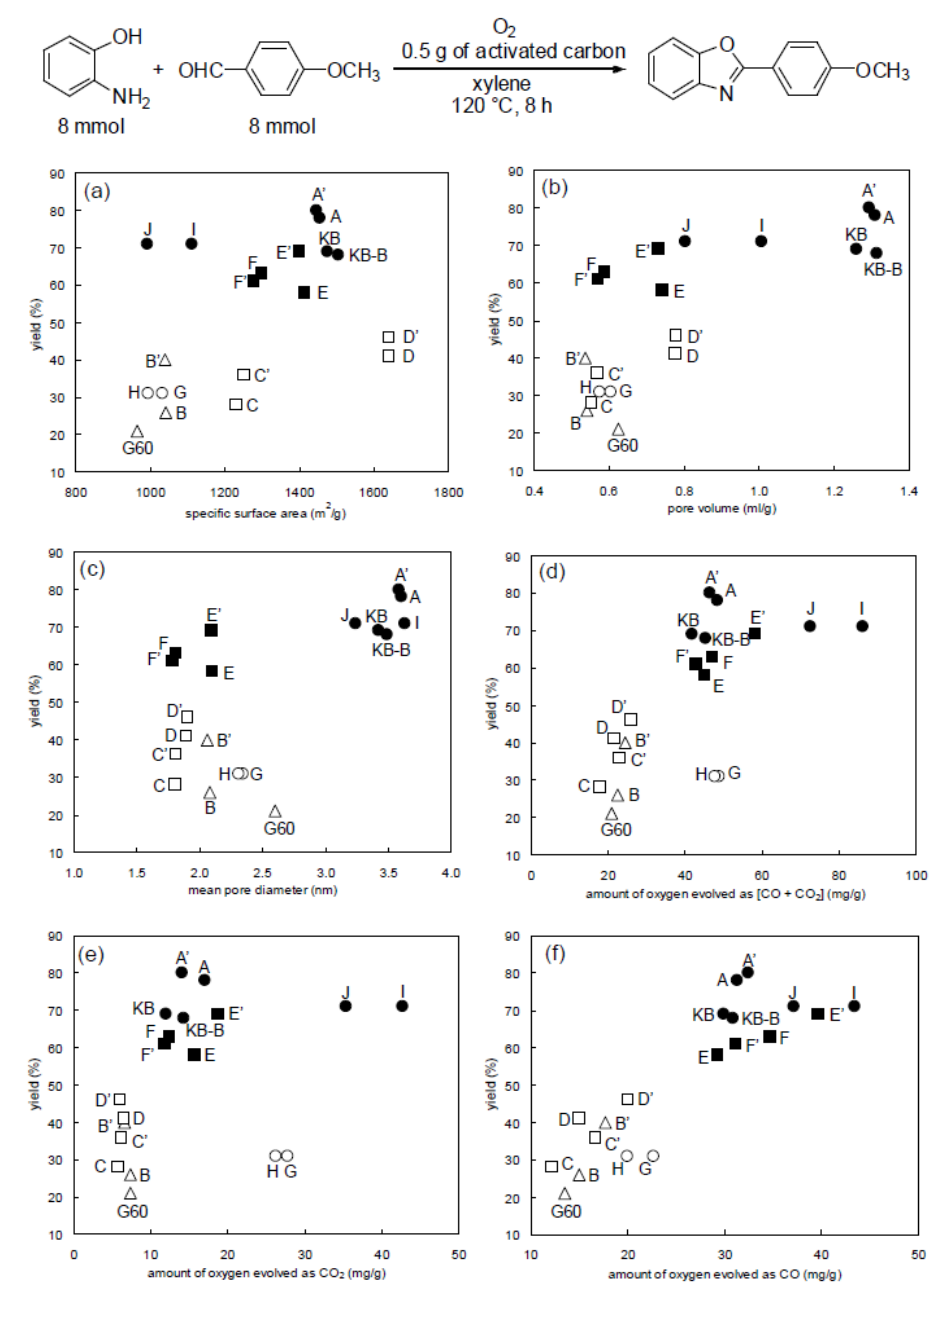
Figure 3. Effect of properties of activated carbons listed in Table 2 on reaction yields.